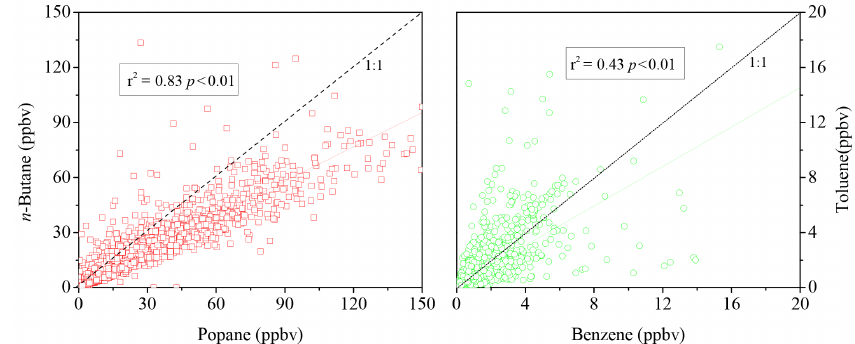
Figure A1. Samples of highly collinear species.